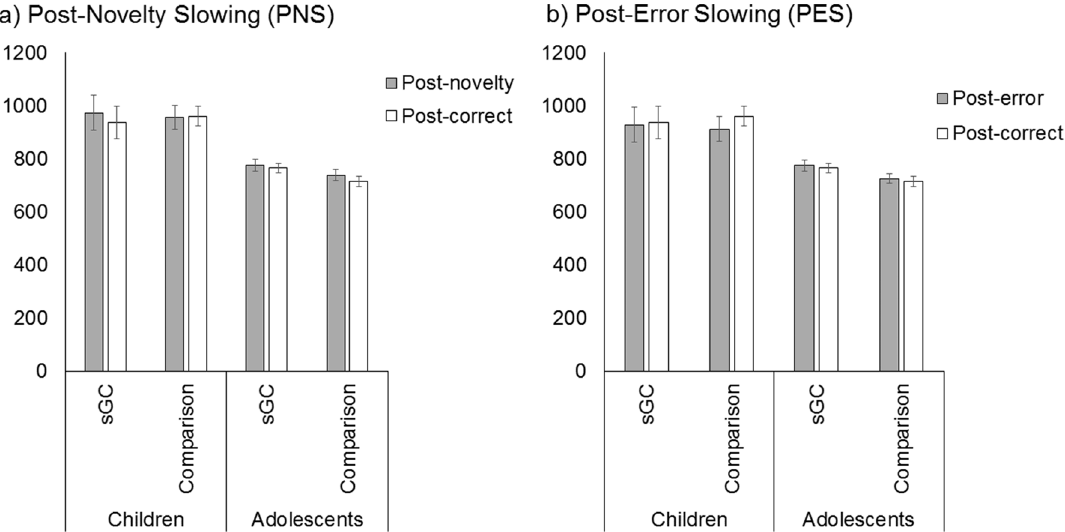
Figure 1. Reaction times for ( a ) post-novelty trials and ( b ) post-error trials. Note that in both cases, performance is comparable across sGC and comparison groups. Error bars represent ± 1 standard error of